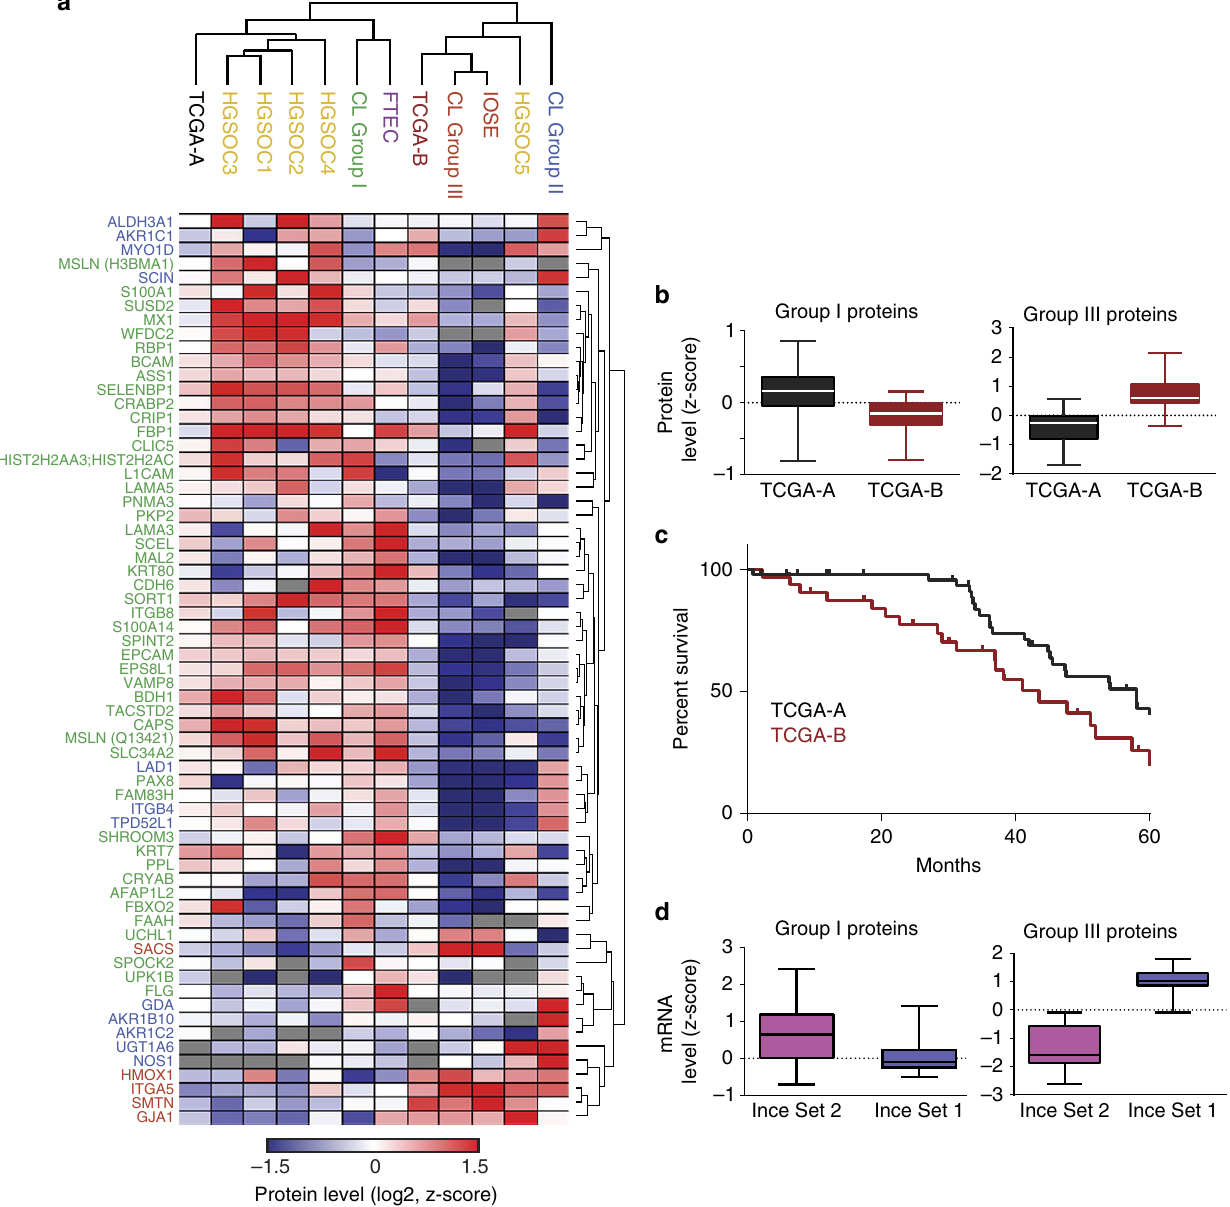
Figure 5 | Clustering of the TCGA tumours based on the 67-protein cell line signature. Hierarchical clustering summary of 84 TCGA tumours with the cell lines, FTECs, IOSEs and HGSOC-1 to -5. ( a ) Hierarchical clustering based on the 67-protein signature was applied to the publically available proteomic profiles of 84 TCGA tumours, and our own data set comprises the cell lines, FTECs, IOSEs and HGSOC-1 to -5 (Supplementary Fig. 5). The average protein levels for each sample group are shown. ( b ) Group I and group III proteins are higher in TCGA-A and TCGA-B tumours, respectively. Z-scored protein levels of group I and group III proteins were plotted as box plots for TCGA-A and TCGA-B tumours. ( c ) TCGA-B tumours (maroon line) are associated with a poorer overall survival compared with TCGA-A tumours (black line). Kaplan–Meier overall survival curves were plotted for patients in TCGA-A or TCGA-B. Survival associated with TCGA-B was significantly lower than that associated with TCGA-A (43.5 months versus 58 months, Mantel–Cox P value ¼ 0.0048). ( d ) The mRNA levels of group I and group III proteins were analysed in a publically available mRNA data set containing two different primary ovarian cancer cell line clusters 35 . Box plots show higher median mRNA levels of group I proteins in the favourable (Ince Set 2) and relatively lower in the unfavourable (Ince Set 1) survival-associated sets, while the converse is true for group III